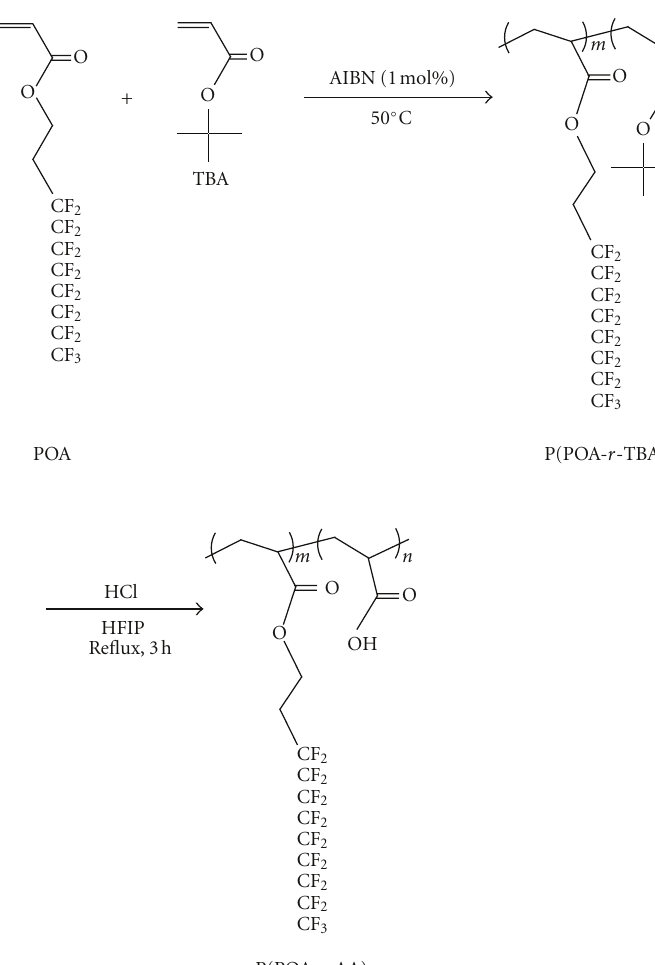
Scheme 3: Synthesis of P(POA- r